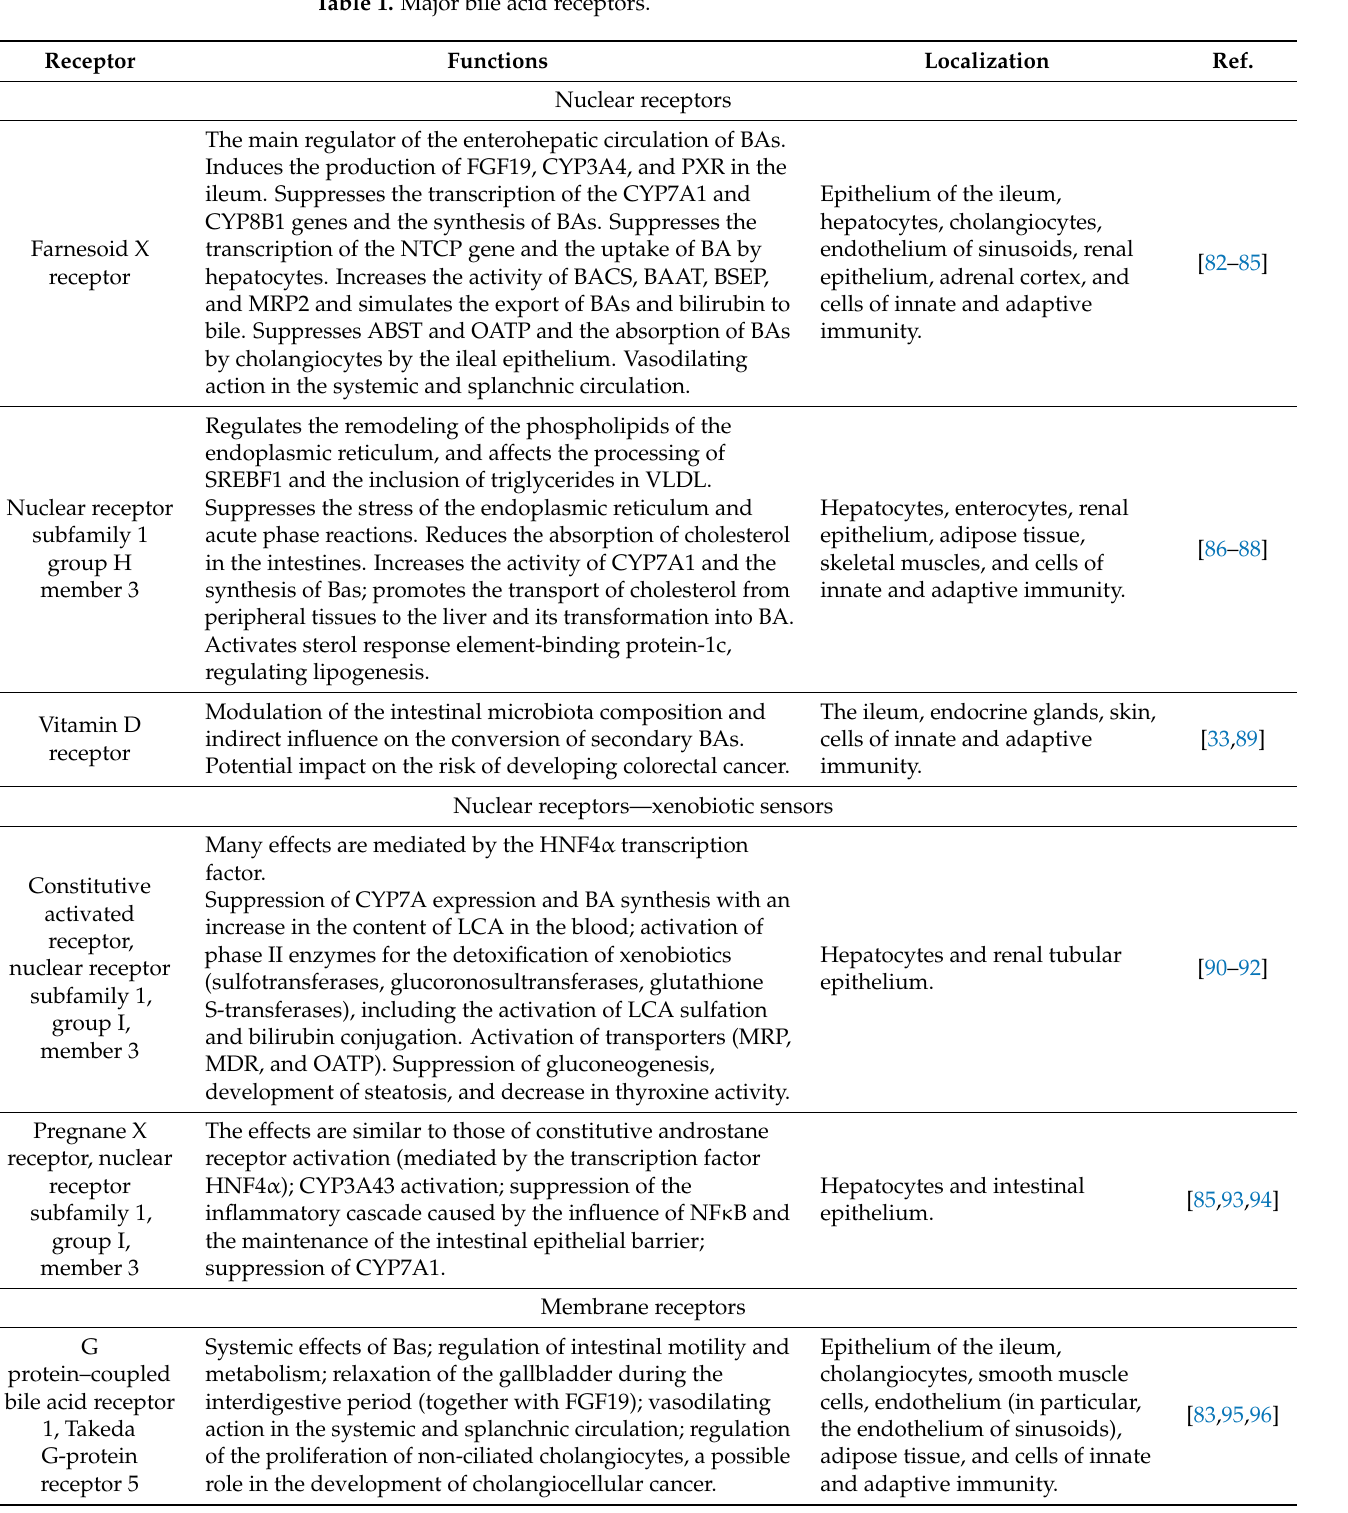
Table 1. Major bile acid